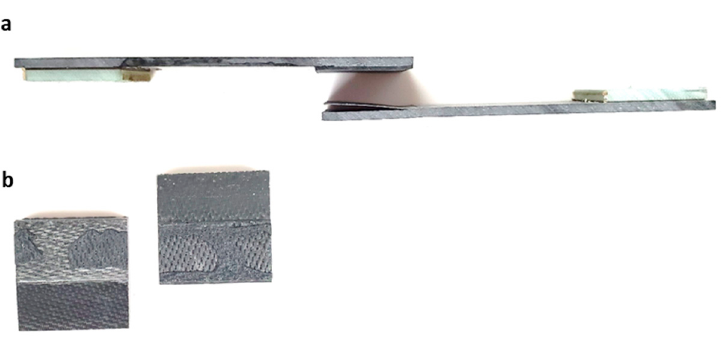
Figure 14. Demonstration of ( a ) a typical delamination failure in single-lap shear samples and ( b ) a cohesive failure in block shear samples.